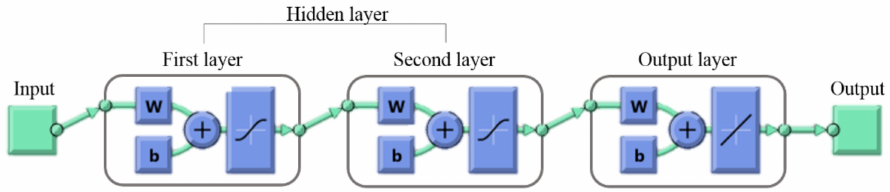
Figure 6. ANN block diagram of